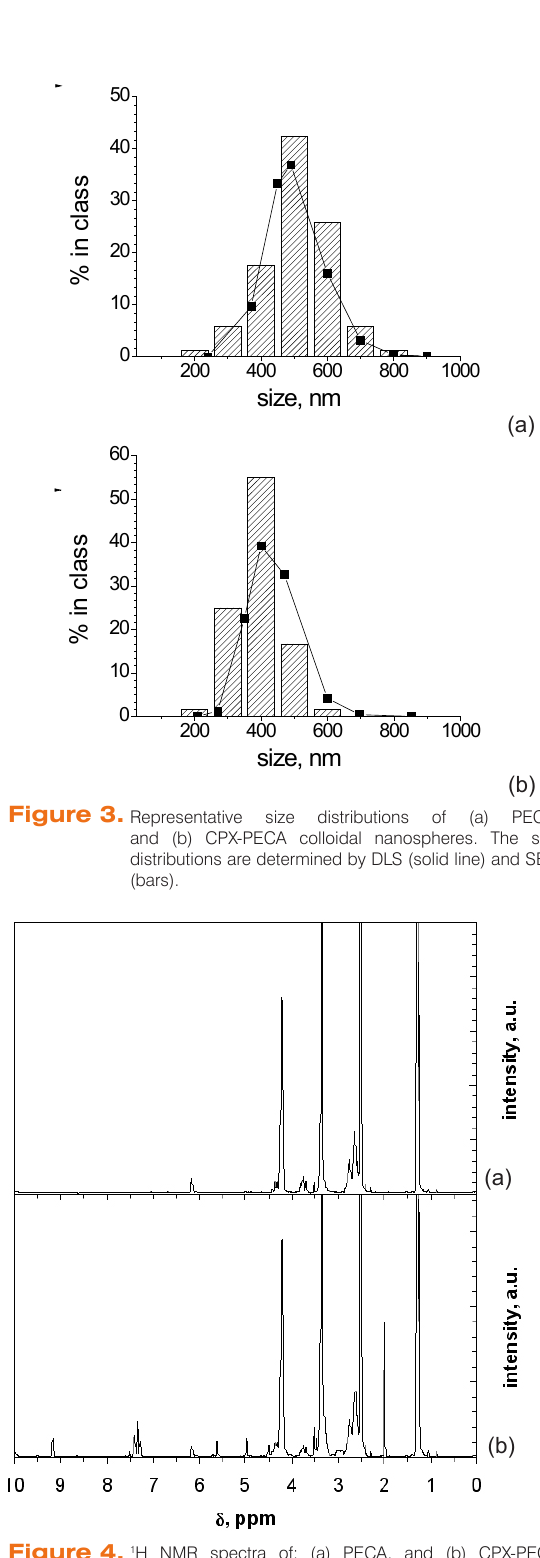
Figure 4. 1 H NMR spectra of: (a) PECA, and (b) CPX-PECA (with drug content of 21%, w/w). The CPX-PECA nanoparticles were prepared by using 10 μL mL -1 of ECA and 10 mg mL -1 of